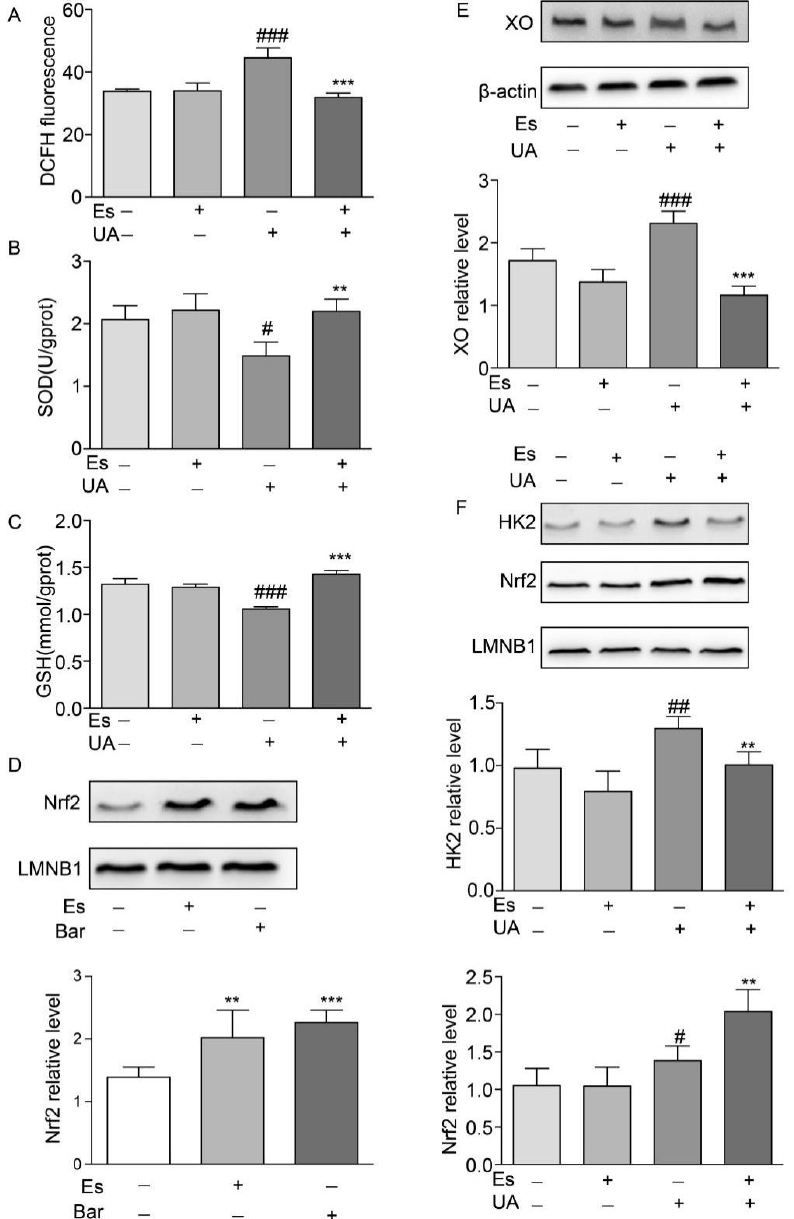
Figure 5. Effects of esculetin on the nuclear translocation of Nrf2 and HK2. ( A ) DCFDA fluorescence. Vertical bars show data with mean ± SD ( n = 6) ( B ) Effects of esculetin on cellular SOD activity. Vertical bars show data with mean ± SD ( n = 6) ( C ) Effects of esculetin on cellular GSH levels. Vertical bars show data with mean ± SD ( n = 6). # p < 0.05, ### p < 0.001 vs. untreated group. * p < 0.05, ** p < 0.01 and *** p < 0.001 compared to UA only. ( D ) Effects of esculetin on nuclear Nrf2 accumulation in NRK-52E cells. Nuclear Nrf2 was determined by Western blot analysis. Vertical bars show data with mean ± SD ( n = 5). ** p < 0.01 and *** p < 0.001 vs. untreated group. ( E ). Western blots of XO in HepG2 cells following UA irritation ± esculetin treatment. ( F ) Western blots of Nrf2 and HK2 in nuclear fractions from HepG2 cells. Vertical bars show data with mean ± SD ( n = 5). # p < 0.05, ### p < 0.001 vs. untreated group. * p < 0.05, ** p < 0.01 and *** p <0.001 compared with UA treated group.